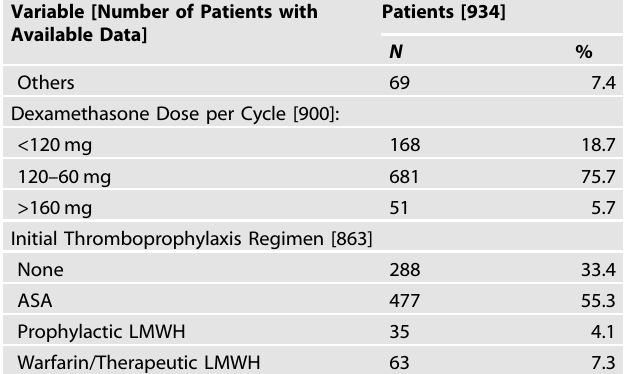
Table 1. Baseline clinical and demographic characteristics.